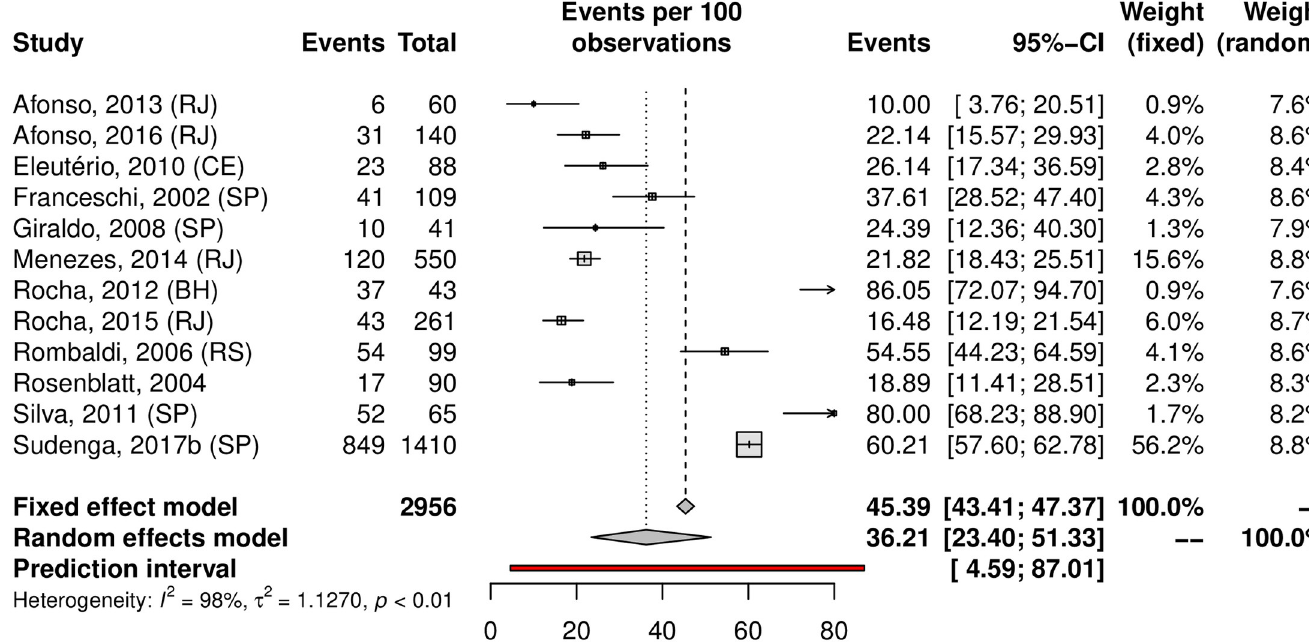
Fig 12. Overall prevalence of penile HPV. Forest plot of metanalysis of studies reporting prevalence of penile HPV infection in Brazil. https://doi.org/10.1371/journal.pone.0229154.g012 PLOS ONE | https://doi.org/10.1371/journal.pone.0229154 February 21,